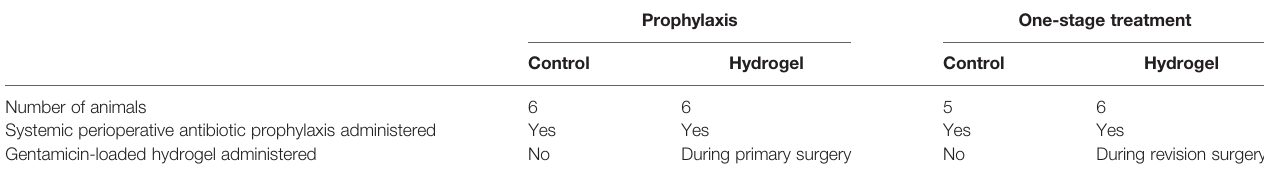
TABLE 1 | Groups and treatment